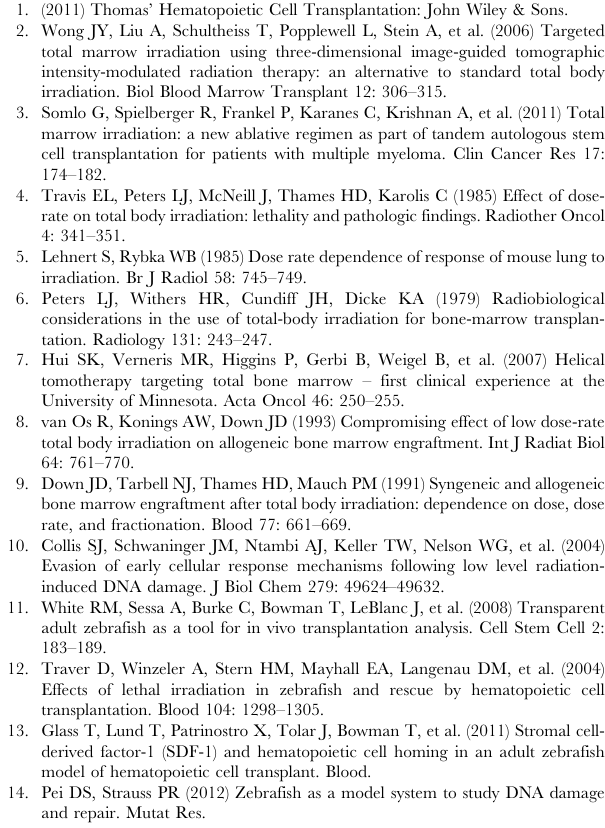
Figure S1 Quantification of TUNEL staining in Kidney sections. Photographs of head, saddle, and tail kidney regions were taken using a 40X objective. The numbers of TUNEL- positive cells were manually counted in each photograph. 3 fish and ten photographs were analyzed per group. Bars show mean and SEM. No significant difference was noted (unpaired t-test). (TIF) Figure S2 Hematopoietic Profiles of WT, ody 2 / + , and ody 2 / 2 Fish. Facs plots of hematopoietic cells pooled from kidneys of several fish of each genotype. Although heterozygous odysseus fish and WT fish both show lymphocyte, precursor, and myelomonocyte populations, myelomonocytes are conspicuously reduced in kidneys of homozygous odysseus mutants. (TIF) Supporting Text S1